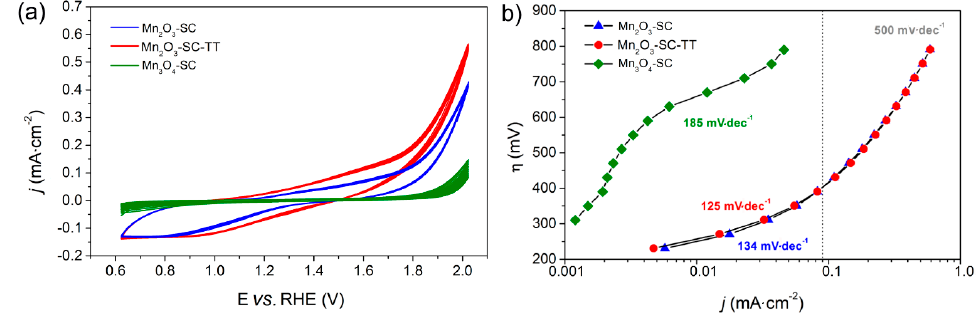
Figure 3. Electrochemical characterization of the SC-films: cyclic voltammograms ( a ) and Tafel plots ( b ) in 0.1 M Na-phosphate buffer (pH = 7.0). Potential (E) is referred to the RHE (see Section 2.5).